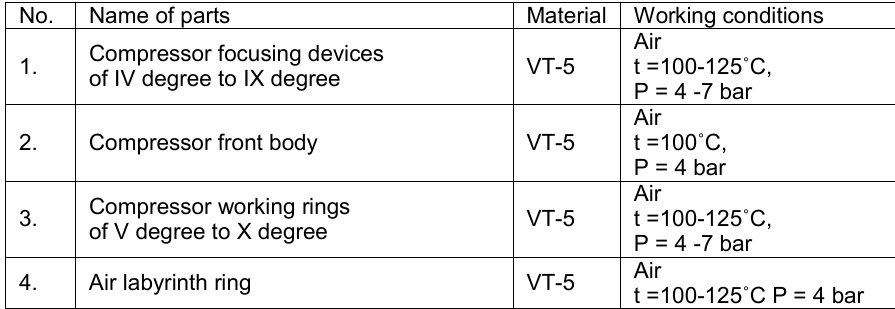
Table 1 – Parts of the TV2-117A turbo-jet engine compressor Tabela 1 – Delovi kompresora turbo-mlaznog motora